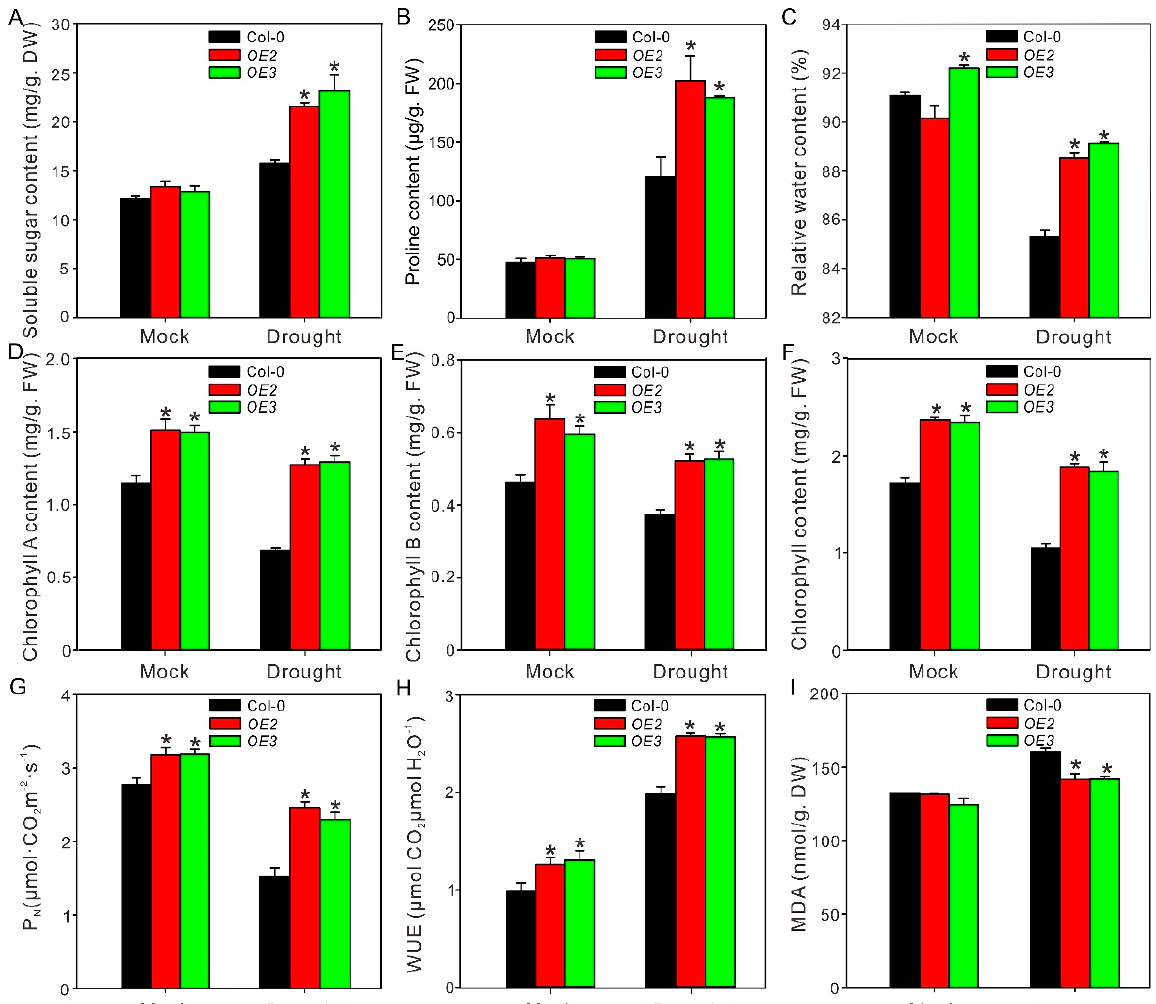
Figure 6. Several physiological parameters of the drought-treated wild-type and transgenic plants. Soluble sugar content ( A ), proline content ( B ), relative water content ( C ), chlorophyll A content ( D ), chlorophyll B content ( E ), chlorophyll content ( F ), Pn ( G ), WUE ( H ), and content of MDA ( I ) were tested. Asterisks indicate significant differences from Col-0 (Values are mean ± SE of three replicates. * p < 0.05, one way ANOVA).